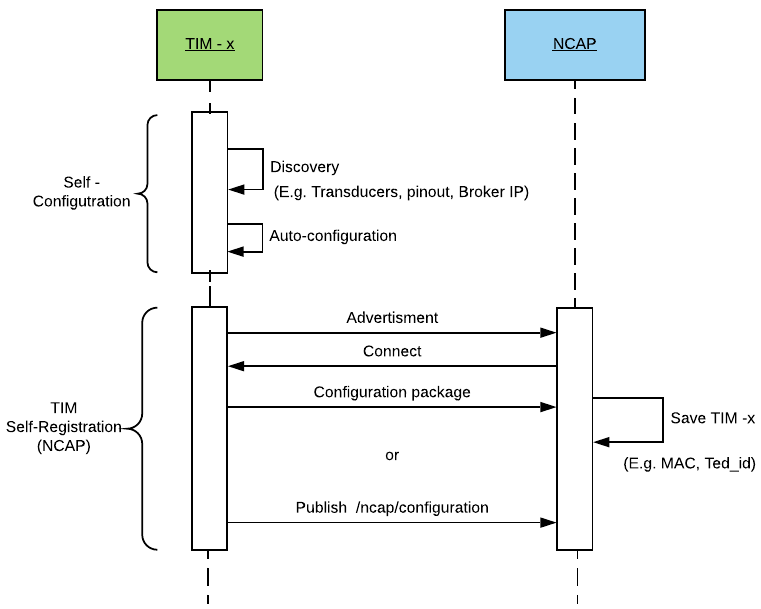
Figure 7. Self-configuration and self-registration of the Transducer Interface Module (TIM) at the Network Capable Application Processor (NCAP)